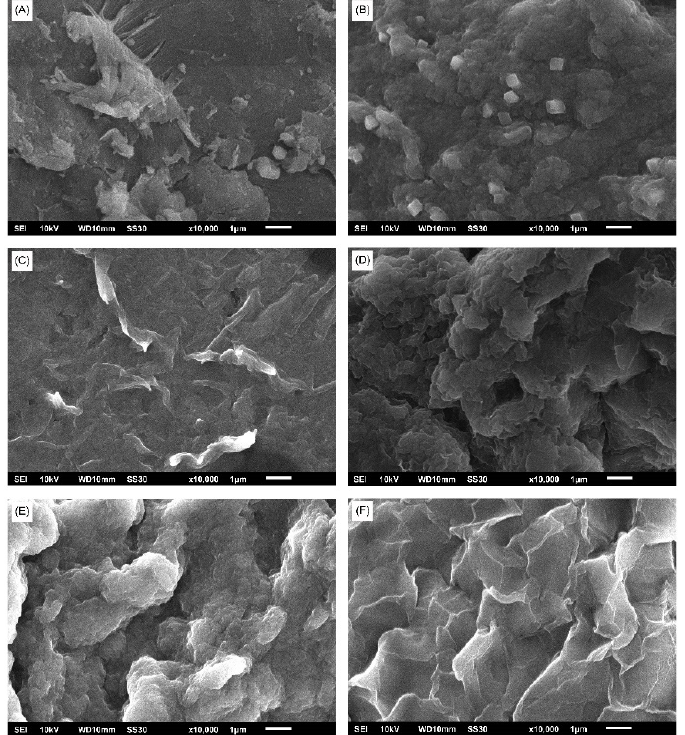
Figure 8. Scanning electron micrographs of ( A ) raw chitosan, ( B ) without surfactant, ( C ) with span 80 addition, ( D ) with span 20 addition, ( E ) with tween 80 addition, ( F ) with tween 20 addition. The chitosan concentration, surfactant concentration, and reaction time were 1% ( w / v ), 7% ( w / w ), and 24 h,